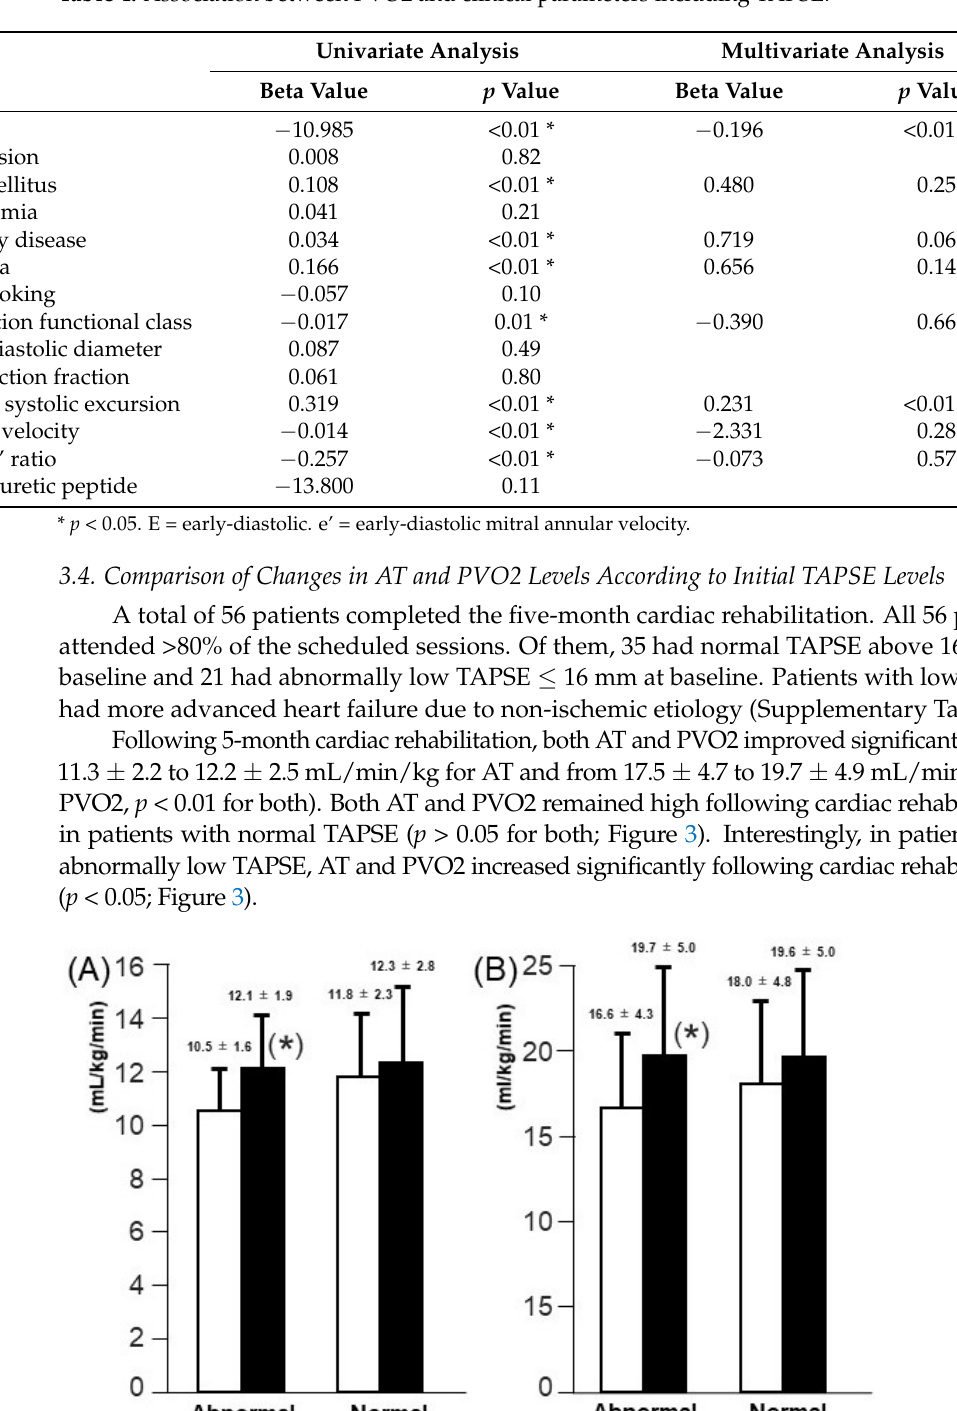
Table 4. Association between PVO2 and clinical parameters including TAPSE.